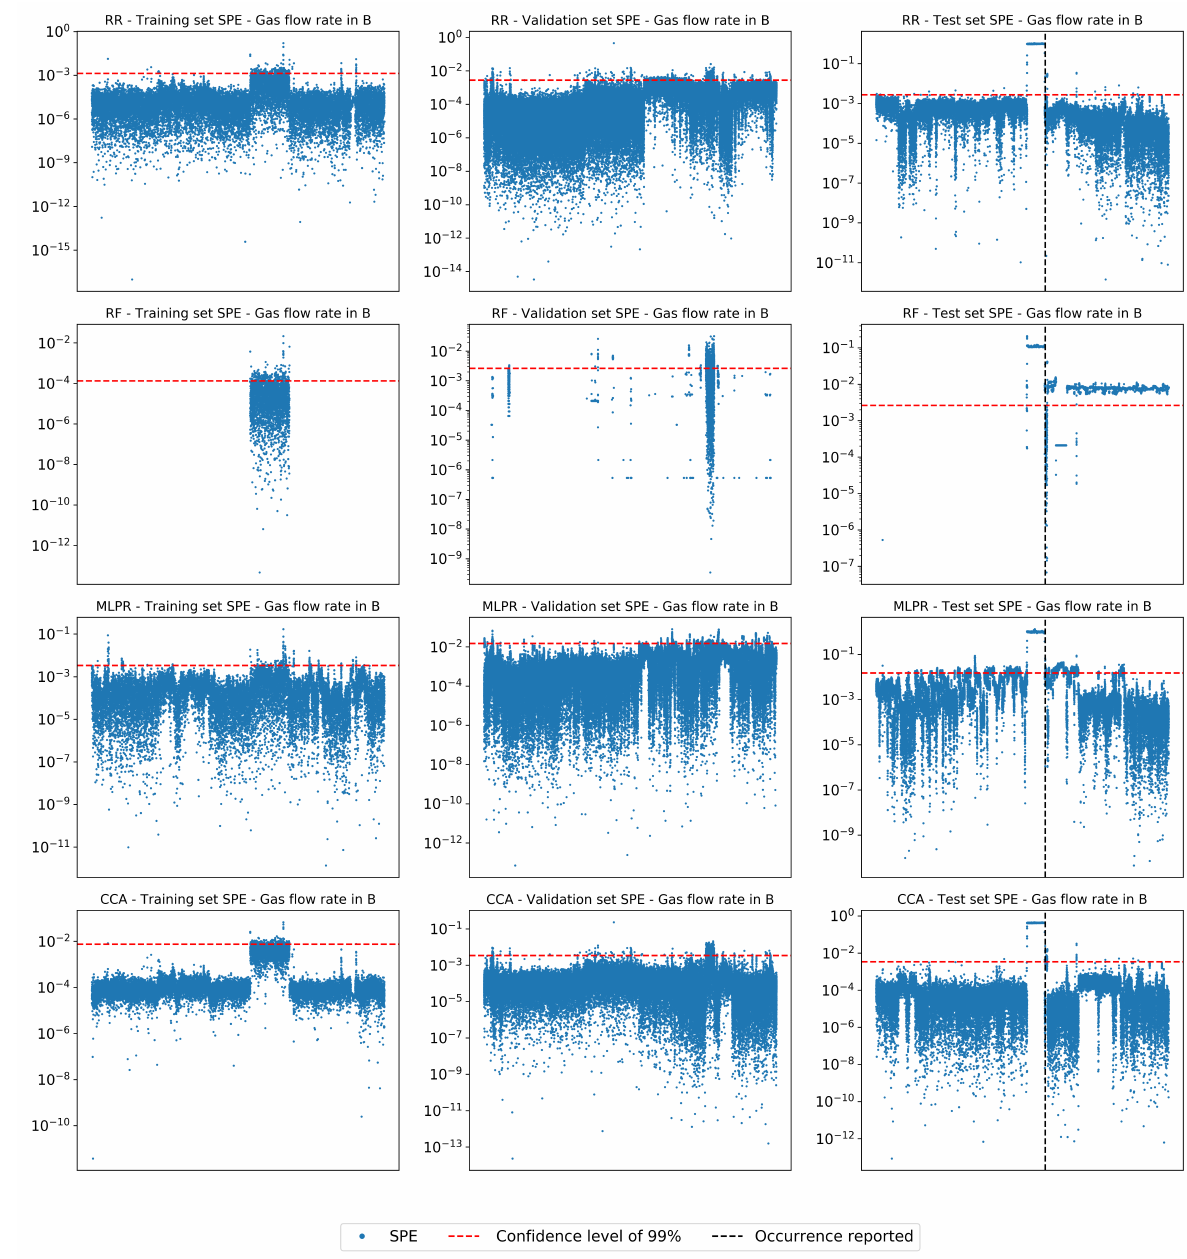
Figure 3. Fault detection index SPE along Fault-FI when the PCMCI algorithm (partial correlation) was used as the variable selection